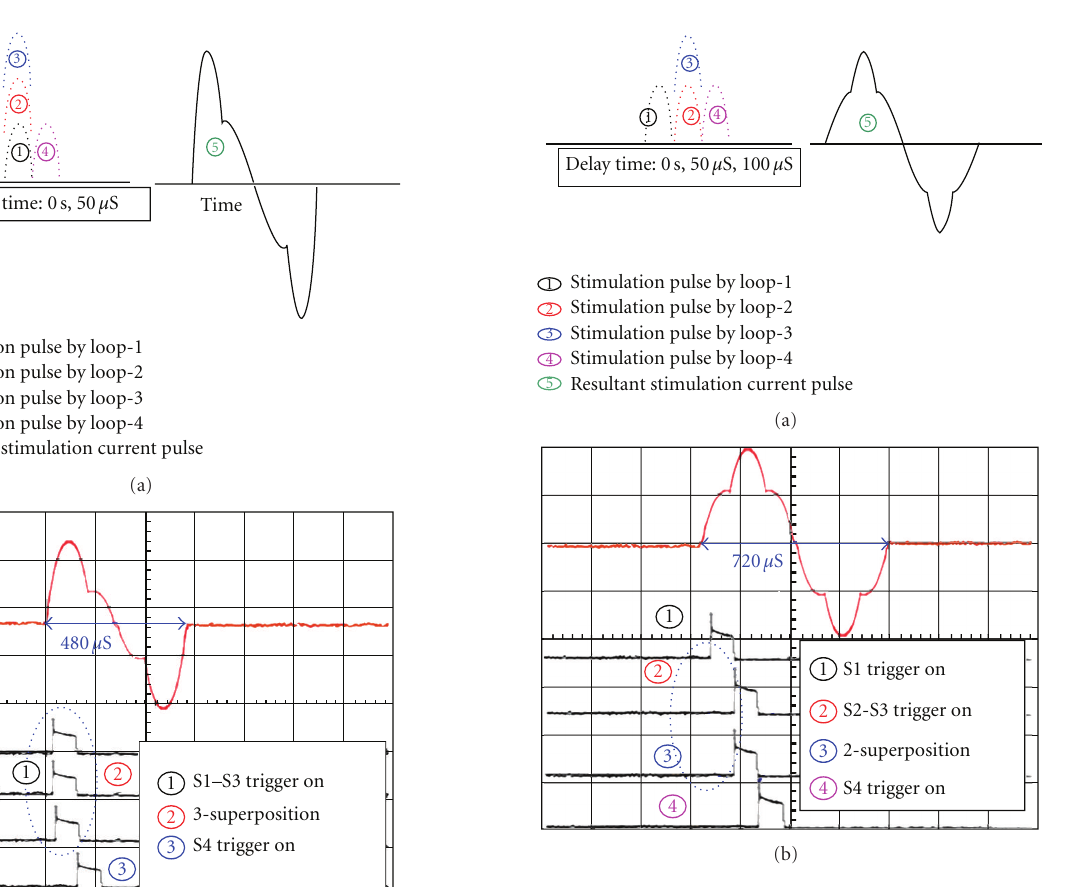
Figure 7: (a) Idea, (b) test. S1 → S2, S3 → S4: trigger on (delay: 0s, 50 μ S, 100 μ S; pulse width: 720 μ